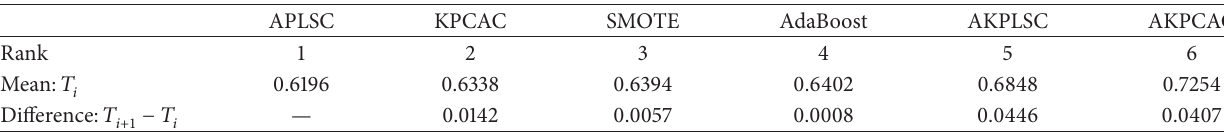
Table 5: Tukey’s test result for the six